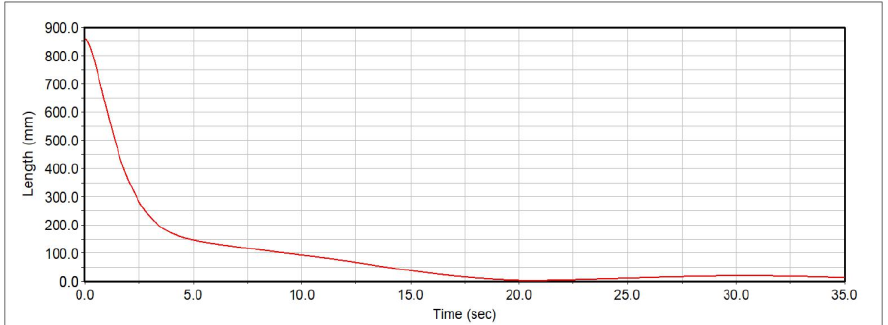
Figure 17. Deployment of the LDR: Distance measurement vs.